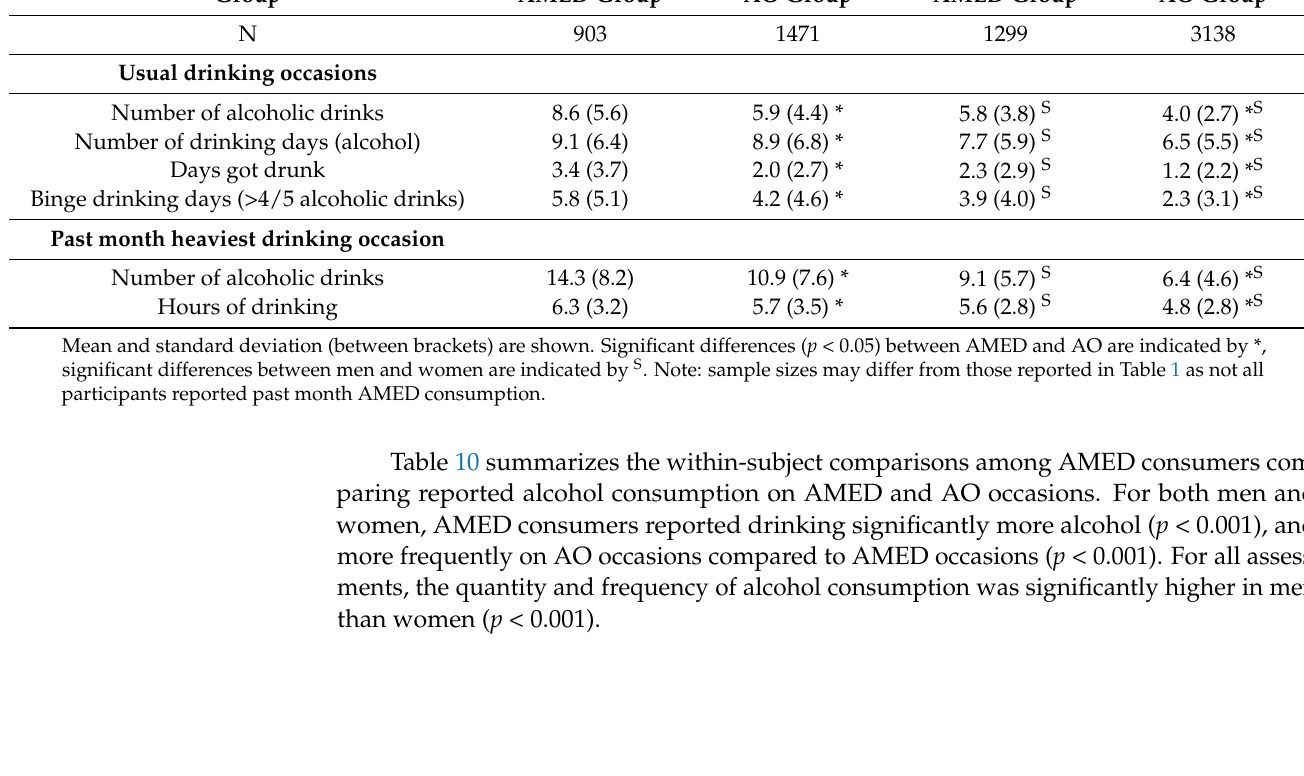
Table 9. Past month alcohol consumption of AMED and AO consumers on usual AO occasions (between-group comparisons). Between-Group